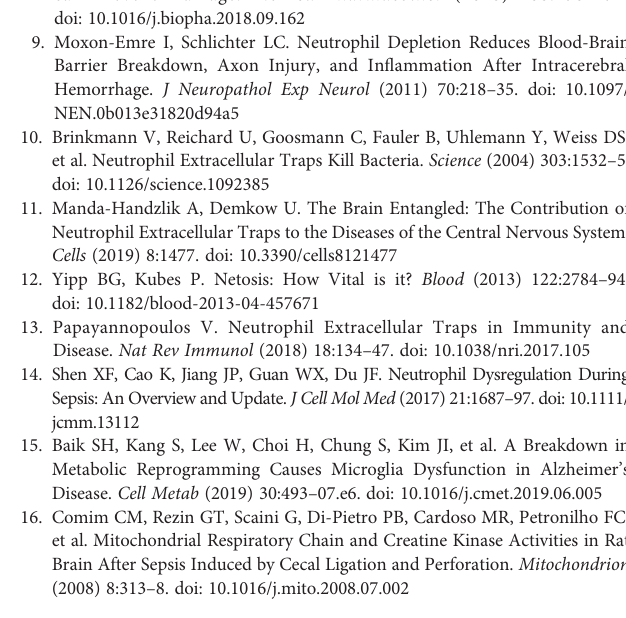
Supplementary Figure1 | Animalsicknessassessmentscoreinthesham-operated group and in the different sepsis groups treated with saline, KYNA, SZR-72 and SZR- 104taken16haftersepsisinduction.Theplotsdemonstratethemedian(horizontallinein thebox)andthe25 th (lowerwhisker)and75 th (upperwhisker)percentiles.Kruskal – Wallis test, Dunn ’ s post-hoc test; * P < 0.05 vs . sham-operated group. Supplementary Figure 2 | Cerebellar (A) and hippocampal (B) wet weight/body weightratiointhesham-operatedgroupandinthedifferentsepsisgroupstreatedwith saline, KYNA, SZR-72 and SZR-104. The plots demonstrate the median (horizontal line in the box) and the 25 th (lower whisker) and 75 th (upper whisker) percentiles. Kruskal – Wallis test, Dunn ’ s post-hoc test; * P < 0.05 vs . sham-operated group. Supplementary Figure 3 | Correlation between plasma citrullinated histone H3 (CitH3) and plasma S100B values in septic rats. Spearman ’ s correlation coef fi cient r values and (null hypothesis-related) P values are provided, regression line and 95% con fi dence interval are